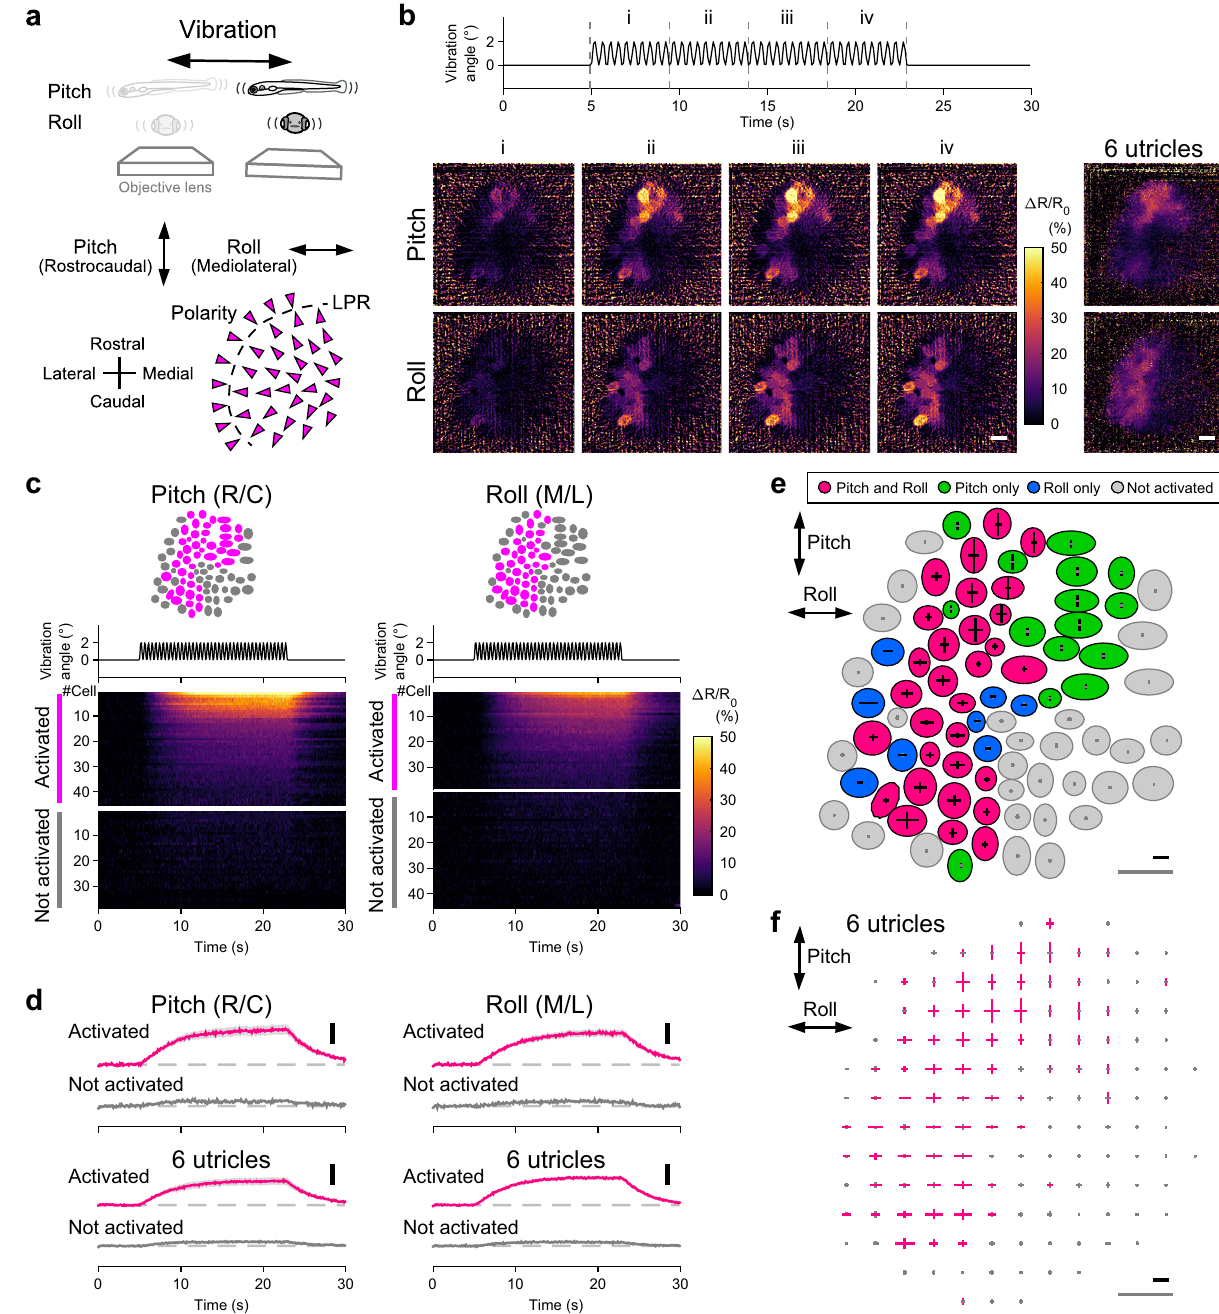
Fig. 3 | In vivo Ca 2+ imaging visualizes a subset of utricular HCs receiving head Vibration time course (middle). Δ R / R 0 per HC (bottom). R/C: rostrocaudal; M/L: vibration.a SchematicshowingimagingofutricularHCsduringvibrationinpitch/ mediolateral. d Mean Δ R / R 0 time course in HC groups in ( c ) (top). Pitch: 45 cells activated;38cellsnotactivated.Roll:38cellsactivated;45cellsnotactivated.Mean roll axis (top). Hair-bundle polarity (arrowheads) and vibration axes (double- ofthe6utricles(bottom).Deviation(SEM)isshowningray.Vibrationtimecourseis headed arrows) (bottom). The same orientation applies to ( b ), ( c ), ( e ), and ( f ). b Example of HC responses to vibration stimulus in pitch and roll axes (see Sup- the same as in C. Scale bar: 10% Δ R / R 0 . R/C: rostrocaudal; M/L: mediolateral. Example( e :thesameutricleshownin[ b ])andsummary( f )ofHCresponsevectors. plementaryMovie4).Vibrationtimecourse(top).Sequentialimagesshowingmean “ i ” to “ iv ” (left).Average of 8 trials. Organ- Δ R/R Orientation of bars indicates stimulus direction. Length of bars indicates Δ R / R 0 0 responses during the time period amplitude ( e ) or mean amplitude per grid that is larger (magenta) or not larger average of the mean Δ R / R 0 responses during the time period “ iv ” in 6 utricles (right).Scalebar:10 μ m. c ExampleofvibrationresponsesperHC.Thesameutricle (gray)than5%( f ,see “ Methods ” ).Blackscalebar:20% Δ R / R 0 .Grayscalebar:10 μ m. Source data are provided as a Source Data fi shown in ( b ). Responses to pitch (left) and roll (right) vibration. HC location (top).